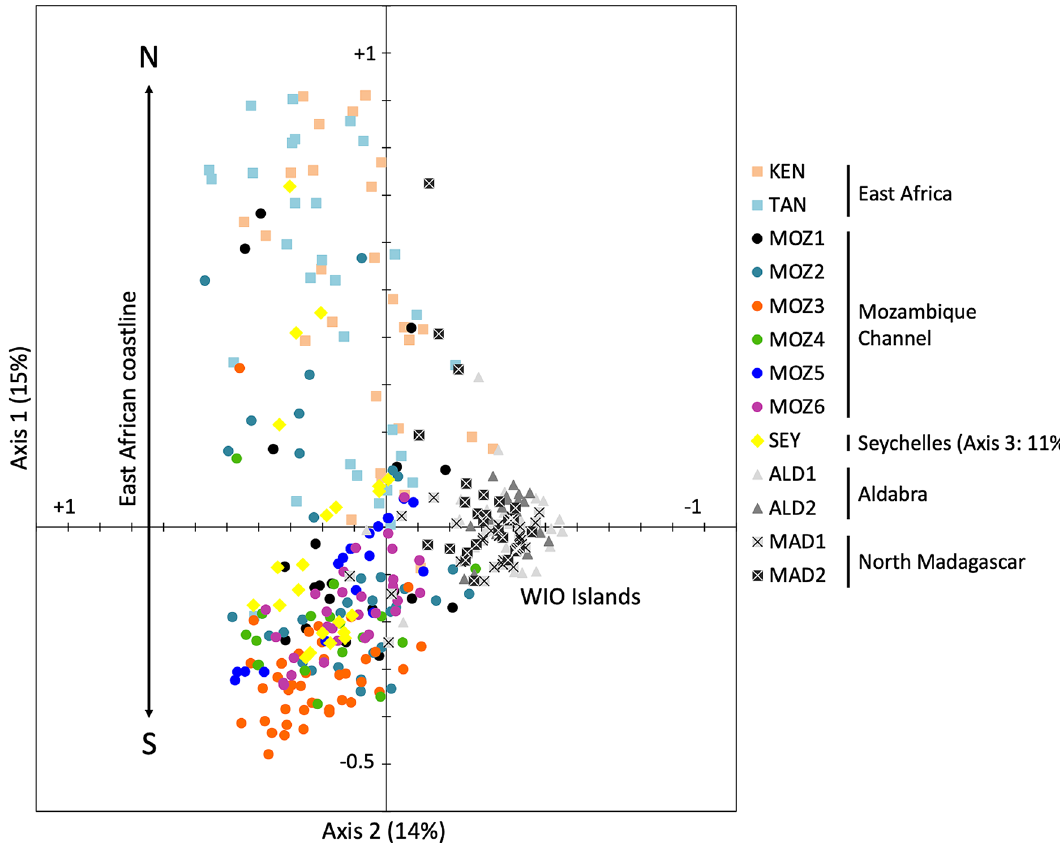
Figure 2. Principal coordinate analysis (PCoA) biplot of individual trees from 13 Rhizophora mucronata populations in the Western Indian Ocean region. Both axes explain a nearly similar amount of variance. A first axis reflects the largest differences in allele distribution along the African continent with enhanced diversity in East Africa (KEN and TAN). The variation along the second axis is mainly caused by a high number of fixed loci within individual mangrove trees of remote and island populations (ALD1, ALD2, MAD1 and MAD2). R. mucronata trees from the Seychelles (SEY) showed intermediate allele diversity and only few fixed loci and hence did not separate as a group except at the third axis (explaining 11% of the variance). Population codes are denoted in Table